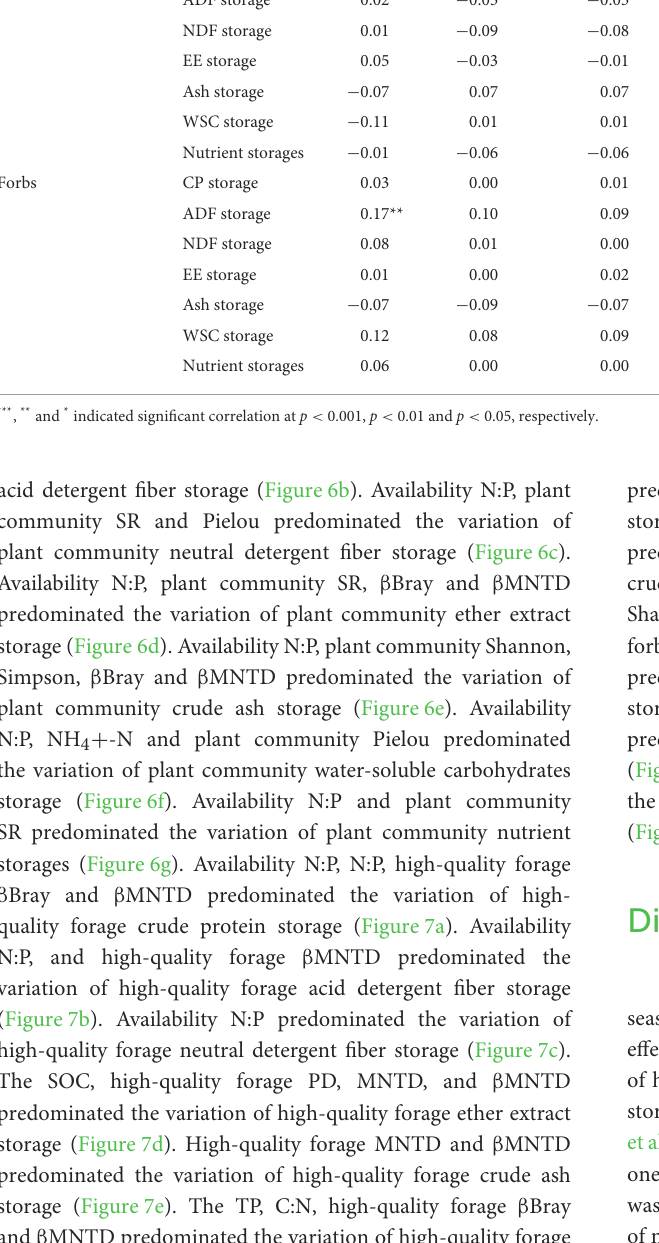
EE storage 0.05